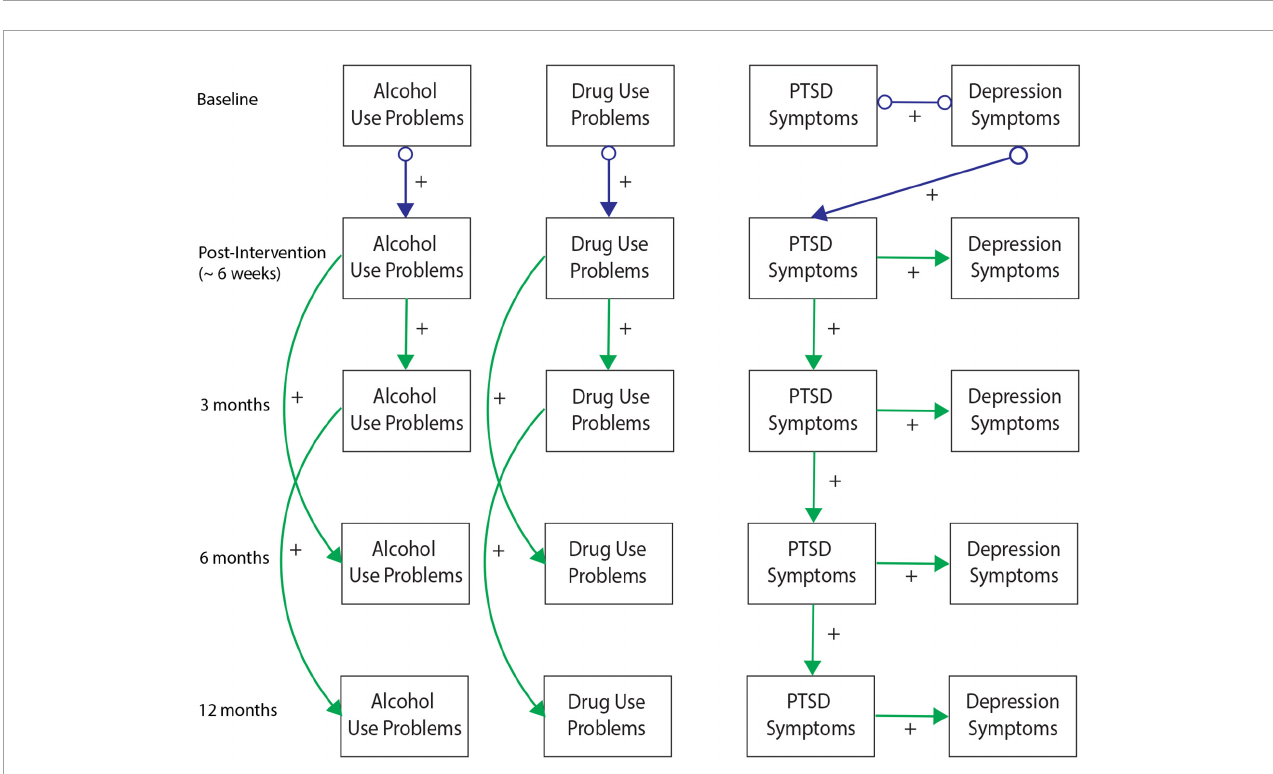
FIGURE4 Greedy Fast Causal Inference (GFCI) graph for the WTTS sample ( n = 116). Second independent replication of causal links between post-traumatic stress disorder (PTSD) symptoms and depression over the course of 12 months in the WTTS sample, which are both independent of drug and alcohol use problems. Colored arrows indicate the level and directionality of the causal edges, with + or – along the edges indicating whether these links cause increases or decreases in scores on the connected measures.